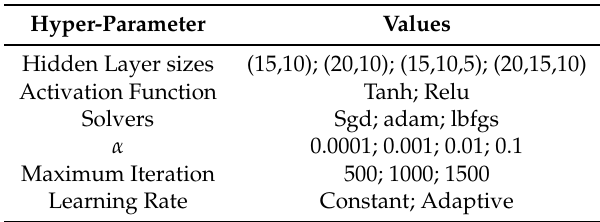
Table 3. Hyper-parameter Values.